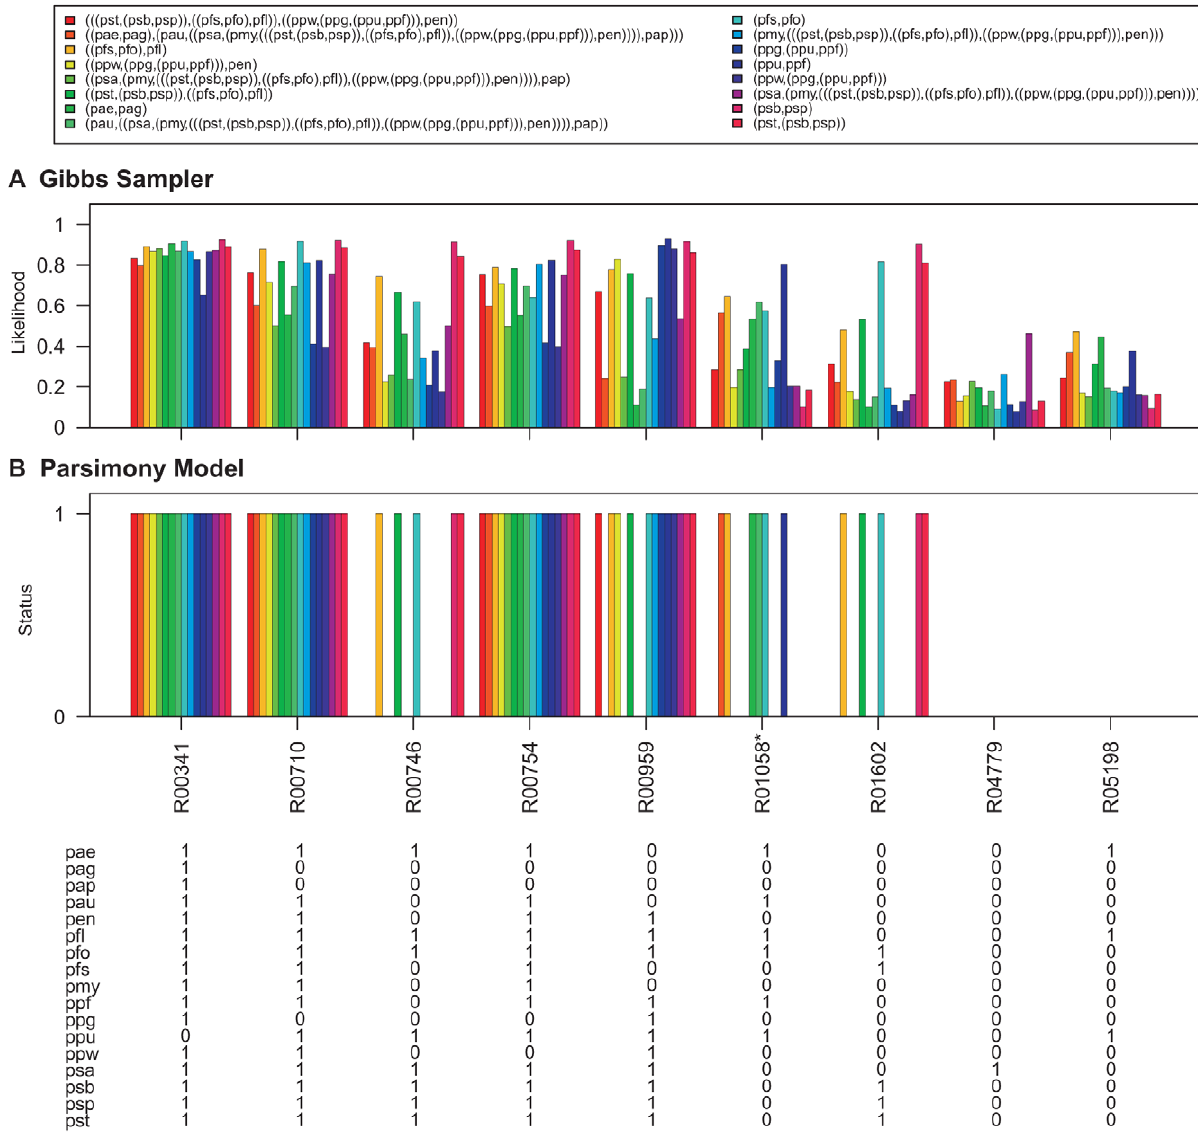
Figure 7. Ancestral network reconstruction for the glycolysis/gluconeogenesis map. The ancestral networks were reconstructed over the Pseudomonas phylogeny shown in Figure 6A. Also shown in the bottom panel is the distribution of reactions across different Pseudomonas strains. (A) Likelihood of being present for alterable reactions at various levels of Pseudomonas phylogeny obtained by calculating the proportion of times each hyperedge was present in the networks sampled by the Gibbs sampler. (B) Reaction status obtained under maximum parsimony calculated using the Fitch algorithm [26]. When assigning the reactions at the ancestral nodes the ties were resolved in favor of presence of reactions. Reactions for which parsimony failed to resolve ancestral predictions at the root are marked with an asterisk (*). Strain abbreviations: pae: P. aeruginosa PAO1, pap: P. aeruginosa PA7, pau: P. aeruginosa PA14, pag: P. aeruginosa LESB58, pen: P. entomophila L48, pfl: P. fluorescens Pf-5, pfo: P. fluorescens Pf0-1, pfs: P. fluorescens SBW25, pmy: P. mendocina ymp, ppf: P. putida F1, ppg: P. putida GB-1 ppu: P. putida KT2440, ppw: P. putida W619, psa: P. stutzeri A1501, psb: P. syringae pv. syringae B728a, psp: P. syringae pv. phaseolicola 1448A, and pst: P. syringae pv. tomato DC3000.